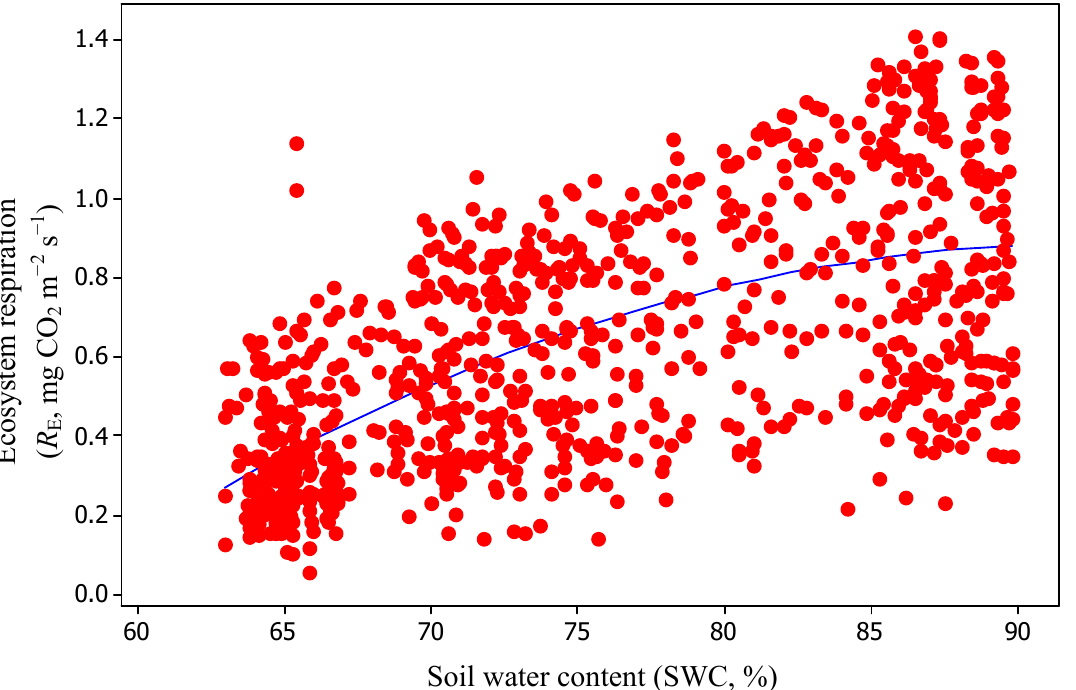
Figure 12. A comparison of SWC versus daytime R Yenicaga peatland ( R 2 = 39.2%; SE = 0.245; n = 896; P < 0.001). adj